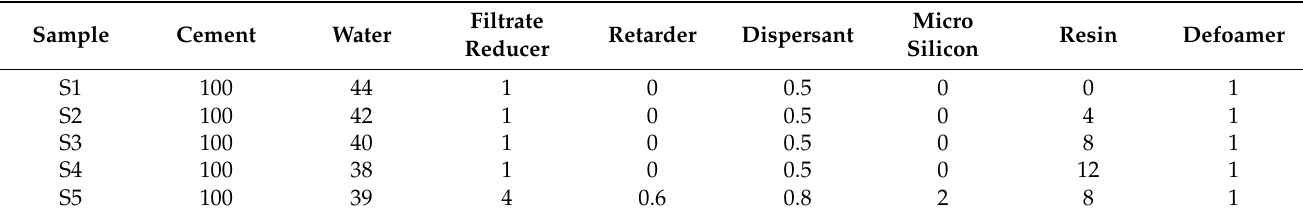
Table 2. Composition of cement slurry. Unit: